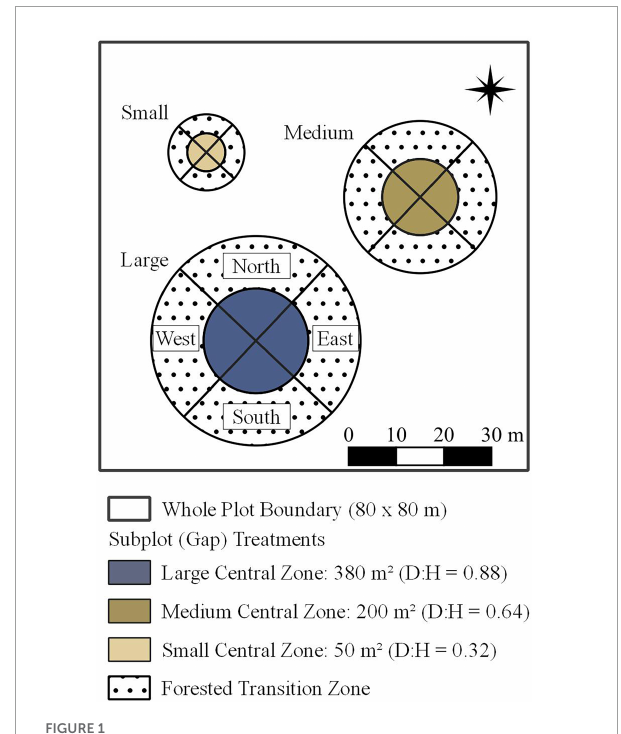
FIGURE1 Whole plot layout with subplot (gap size) treatments. Concentric circles depict zones: the central zone was harvested, and transition zone surrounds closed